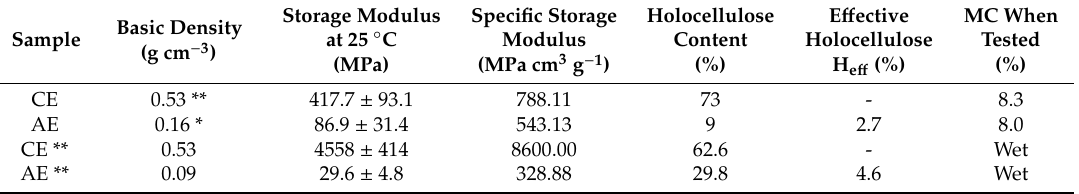
Table 3. Mean values of the measured storage modulus and specific storage modulus calculated as proposed by Pizzo et al. [44]. The holocellulose content and basic density for undegraded contemporary and degraded archaeological elm are also